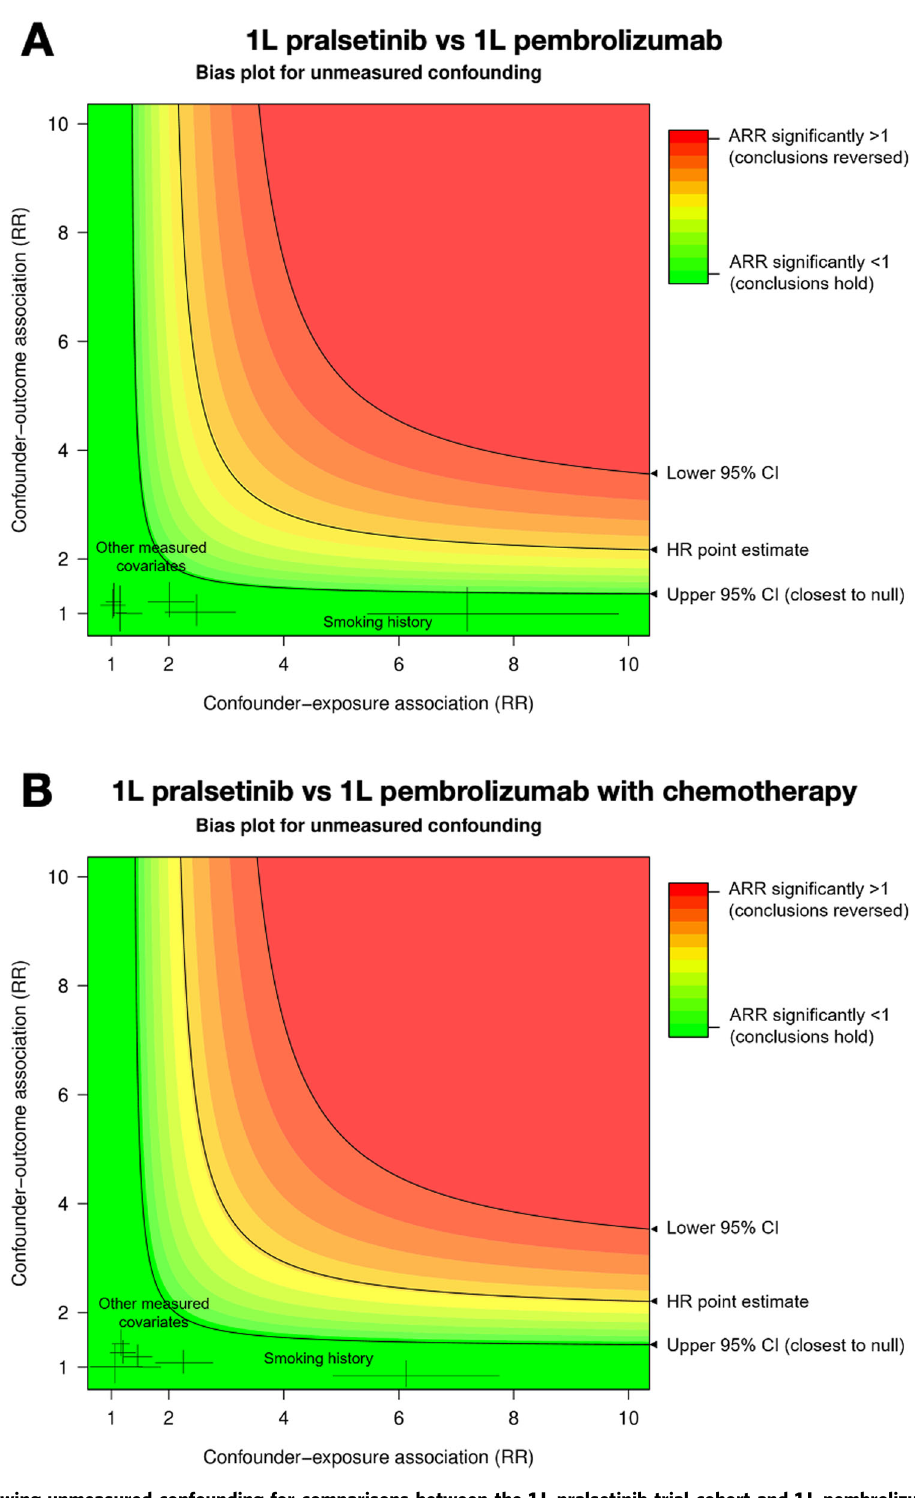
Fig. 2 Bias plots showing unmeasured confounding for comparisons between the 1 L pralsetinib trial cohort and 1 L pembrolizumab cohort, and 1 L pralsetinib trial cohort and 1 L pembrolizumab with chemotherapy cohort. A Bias plots for unmeasured confounding corresponds to the comparison with 1 L pembrolizumab comparison (HR 0.38, 95% CI 0.21 – 0.67), B corresponds to the comparison involving 1 L pembrolizumab with chemotherapy comparison (HR 0.37, 95% CI 0.21 – 0.64). These graphs plot unconfounded treatment effect estimates as risk ratios (ARR adjusted risk ratio) after adjusting for a hypothetical unmeasured binary confounder over a range of confounder-exposure and confounder-outcome associations on the risk ratio scale. The colors map the strength of an unmeasured confounder ( x and y axes) to the robustness of this study ’ s conclusions (color gradient). The worst- case strengths of measured baseline confounders are shown using HRs from the multiple imputation resulting from QBA for missing data assumptions.